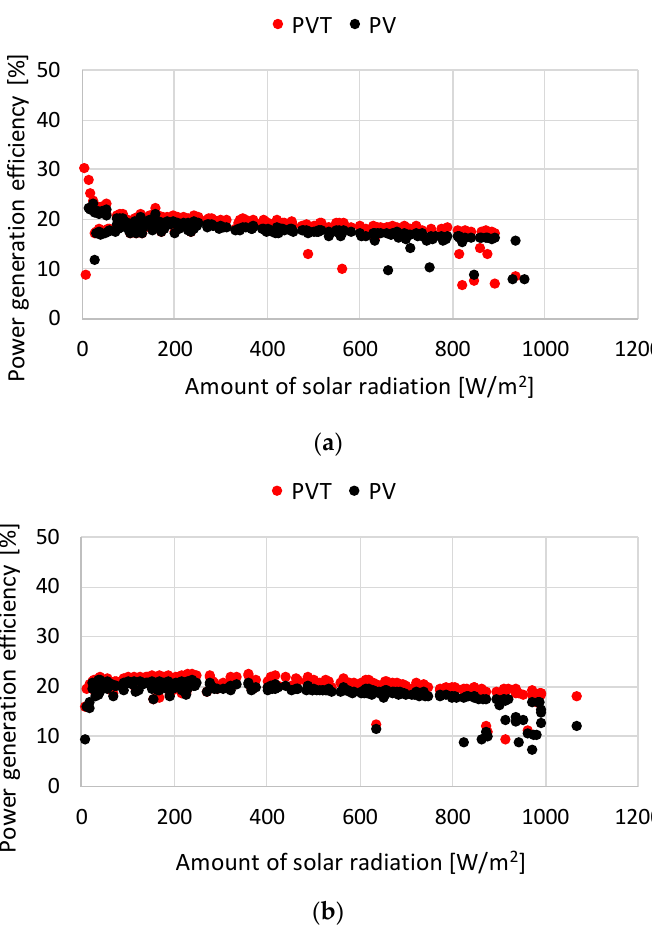
Figure 10. Power generation efficiency of PVT and PV: ( a ) summer; ( b ) winter.